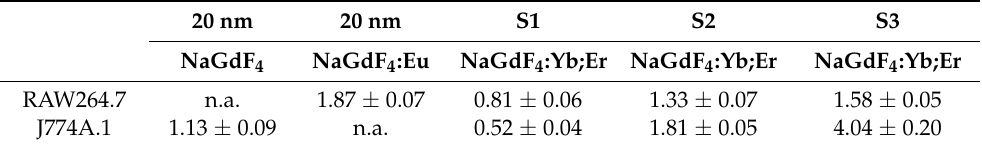
Figure 2. Viability of RAW264.7 or J774A.1 after a 48 ‐ h treatment with NaGdF 4 :Yb;Er (S2), NaGdF 4 or NaGdF 4 :Eu NPs. The average ± SD are shown ( n = 3). Table 1. The toxicity of NaGdF 4 lanthanide doped nanoparticles against the macrophage cell lines. The IC 50 ( µ g/mL) (Promega MTS assay) values are shown ( n = 5); n.a. not assessed.